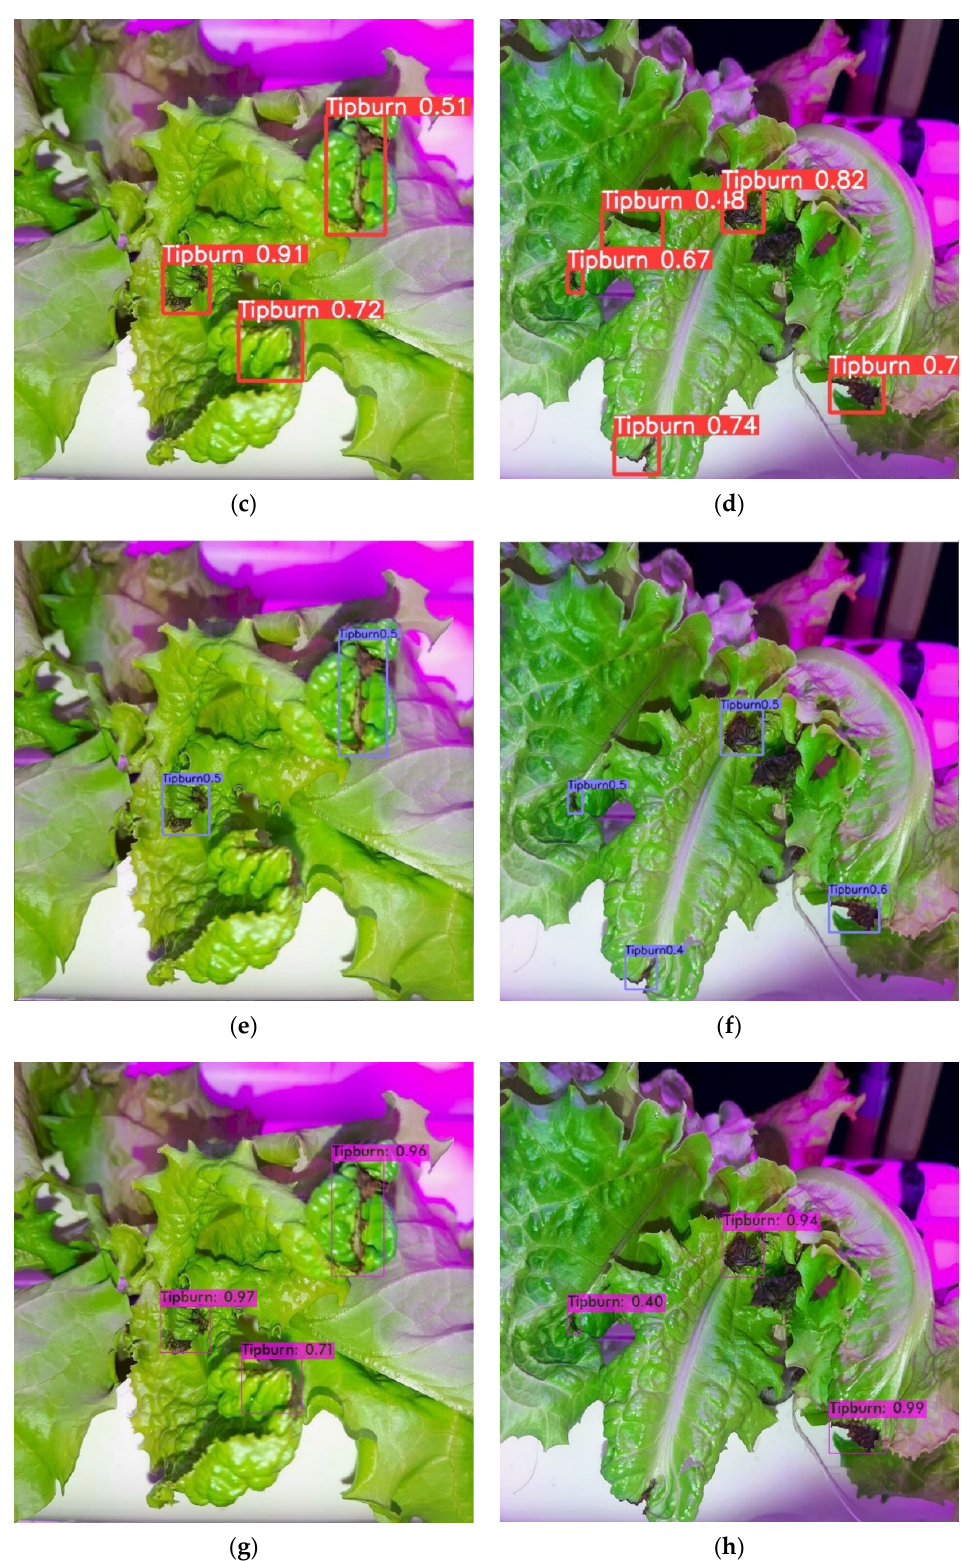
Figure 8. Detection of tip-burn under white/red/blue light conditions from ( a , b ) manually labelled; ( c , d ) YOLOv5; ( e , f ) CenterNet; ( g , h ) YOLOv4.